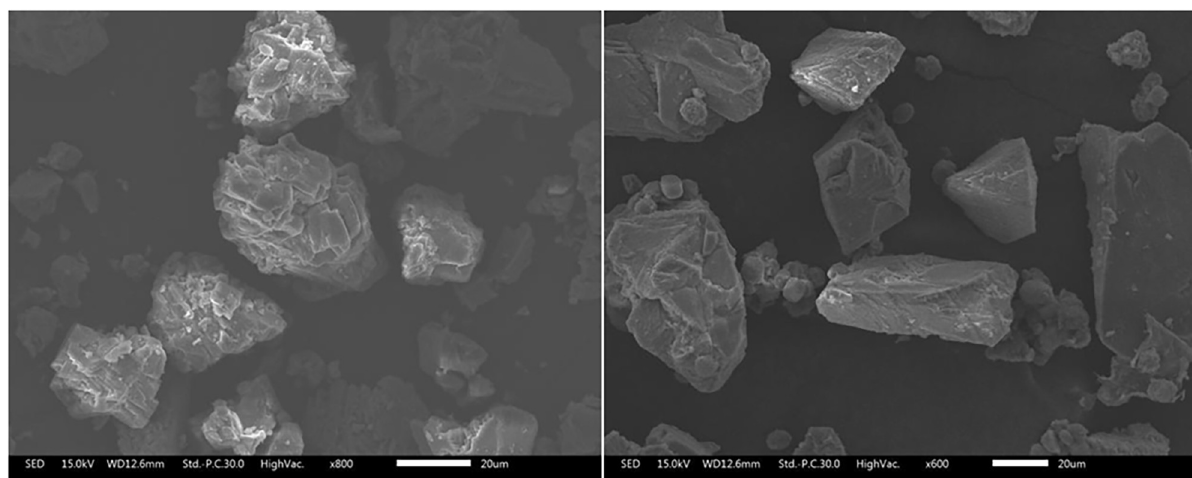
Fig 4. Types of precipitated calcium carbonate crystals at different pH (left 7 and right 9).